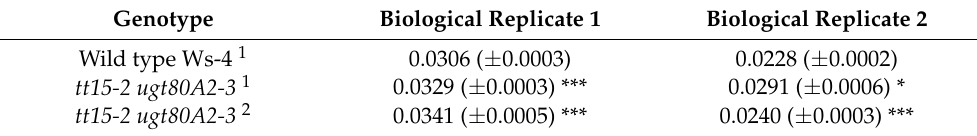
Table 1. Comparison of fluorescence anisotropy for a 20-kDa FITC-polysucrose probe in seed mucilage of the tt15 UGT80A2 mutant with wild-type. Values are arbitrary units with SE values in parentheses ( n > 29) from 15 to 20 different seeds. Asterisks indicate a significant difference from wild type (non-parametric nparcomp multiple comparison test) *** p < 0.001, * p <